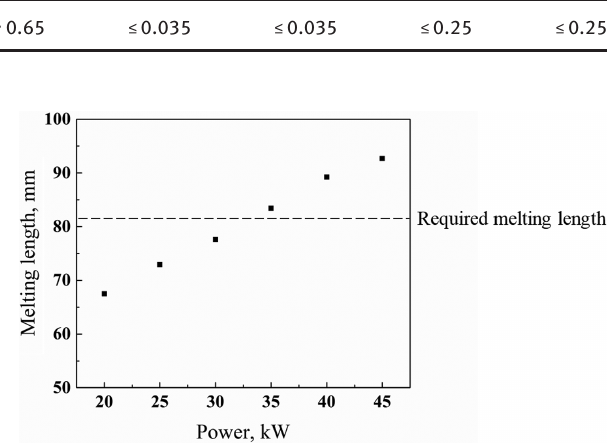
Figure 2: Effect of power on the melting length of the Fe-C alloy.